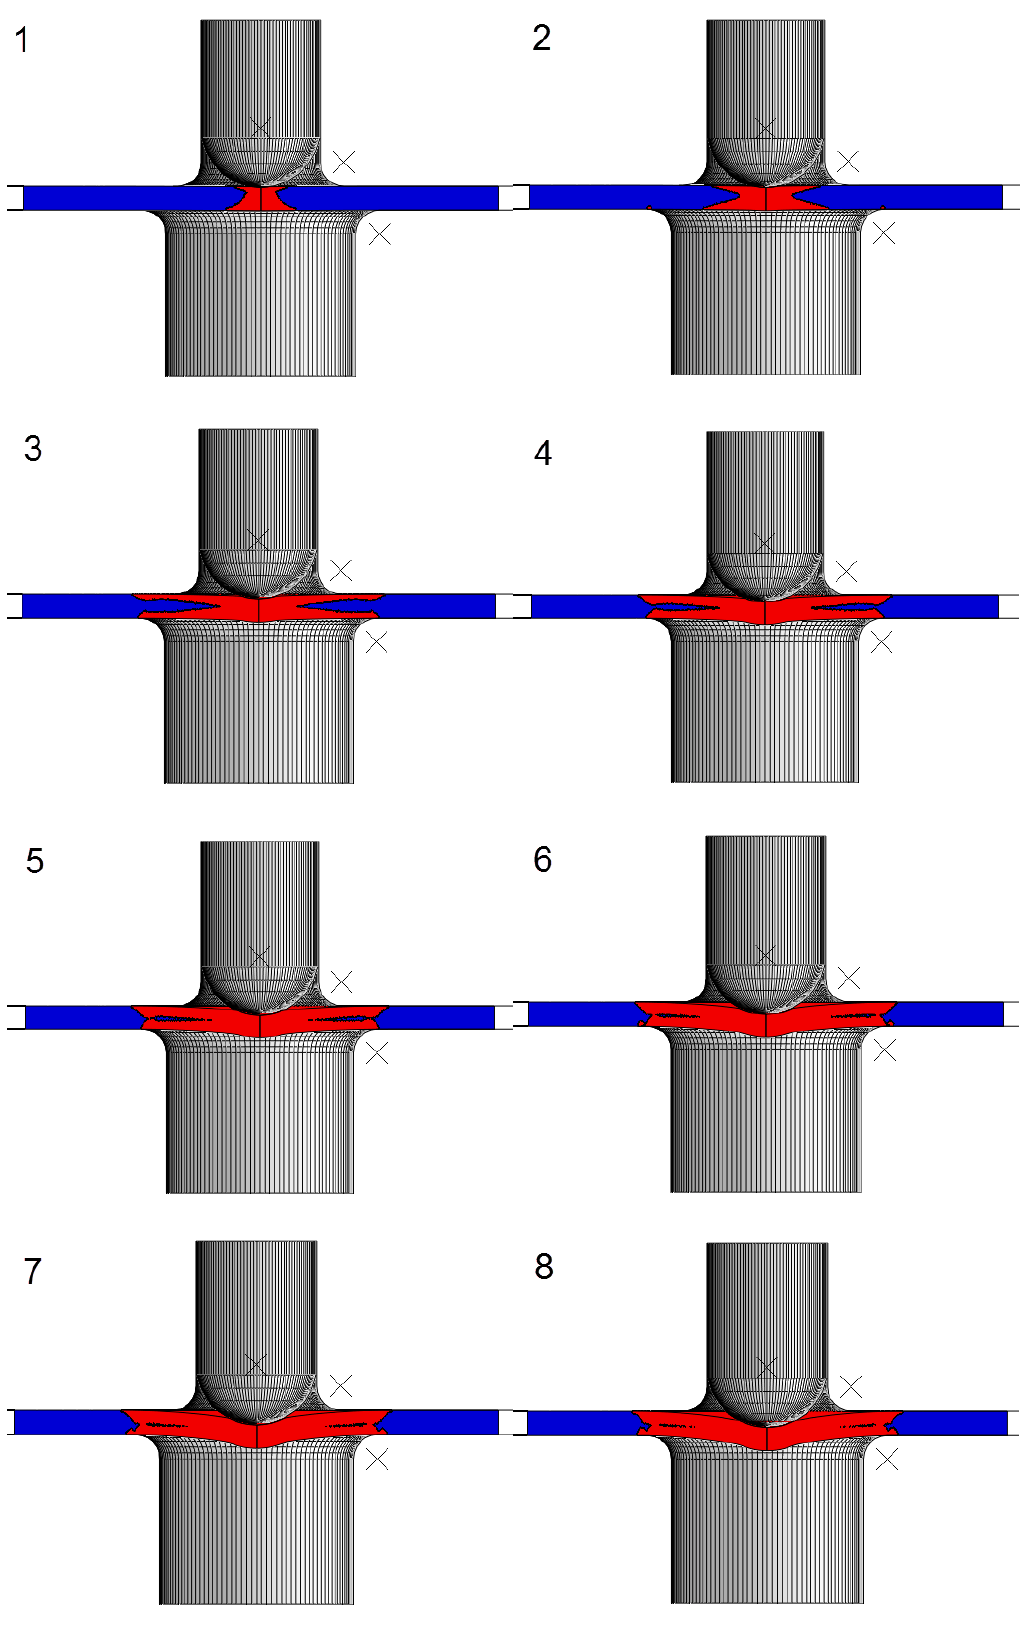
Figure 6. Elastic (blue) and plastic (red) zones in the SPT specimen at positions 1 to 8.